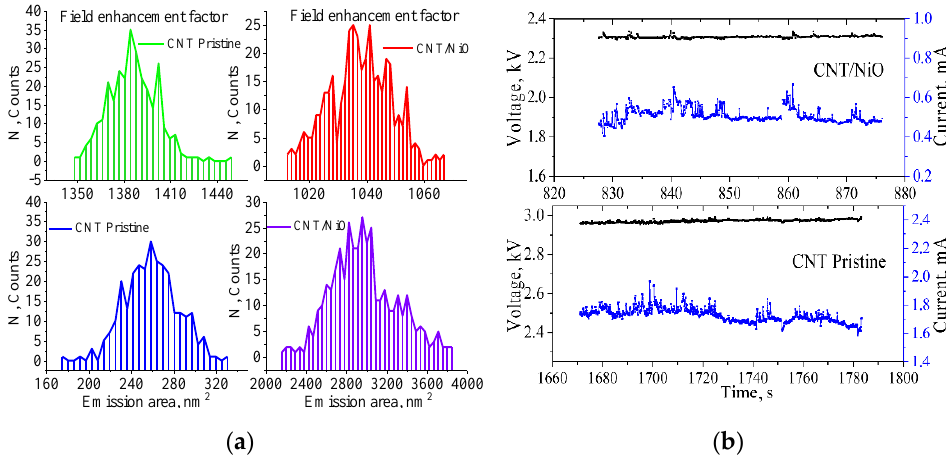
Figure 3. Statistics of the effective field enhancement factor and emission area ( a ) and the current fluctuations of the samples ( b ).